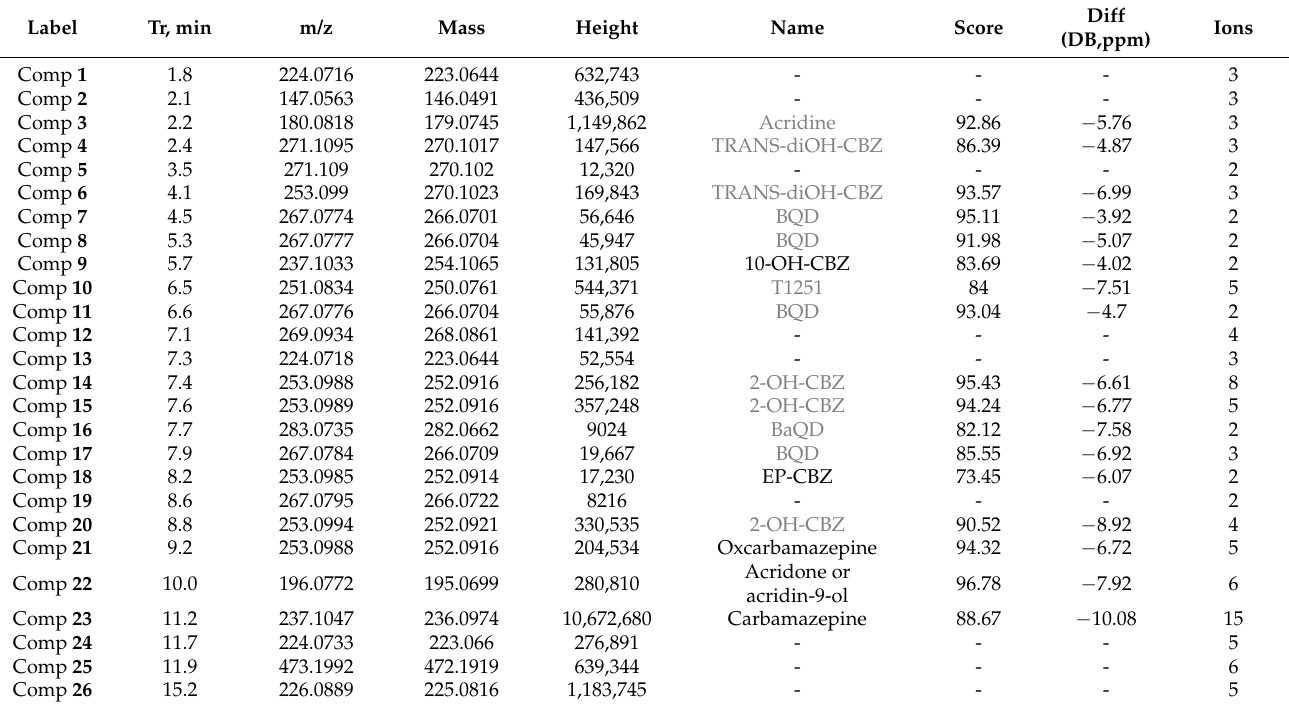
Table A2. Results of screening of major compounds. Sample pH = 3.0. Experimental conditions: [CBZ] = 50.0 mg/L;